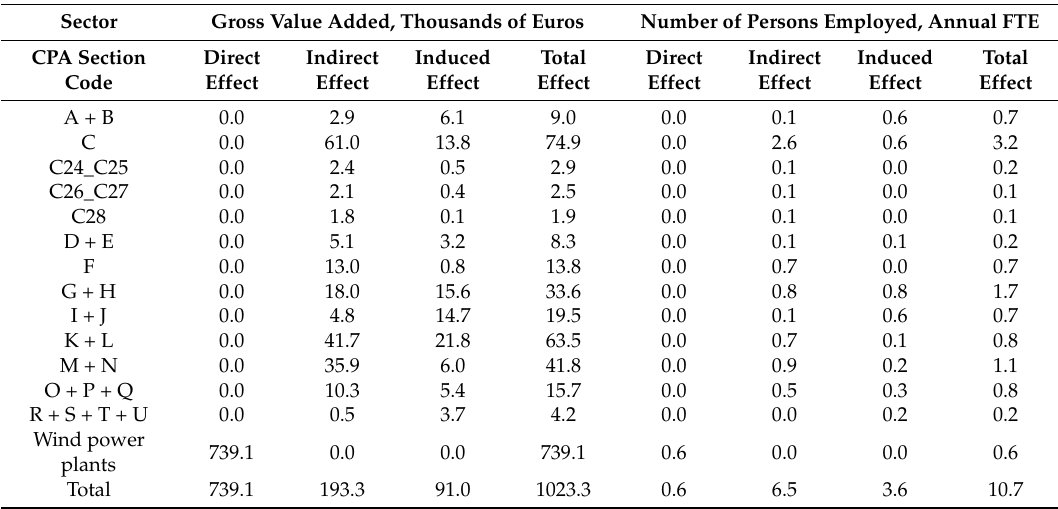
Table 7. Intermediate consumption channel, total effects of energy production valued 1 million euros.